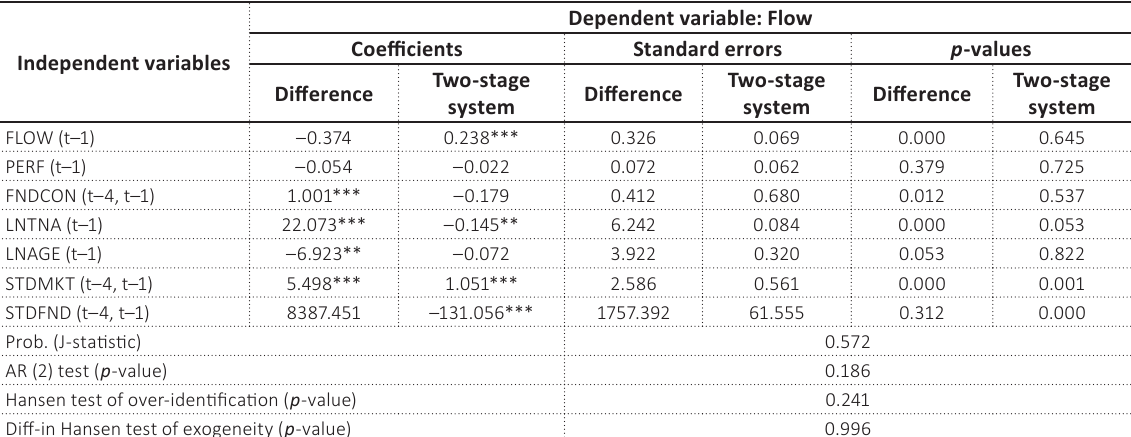
Table 4. Flow-performance with changing conditions from the fund market